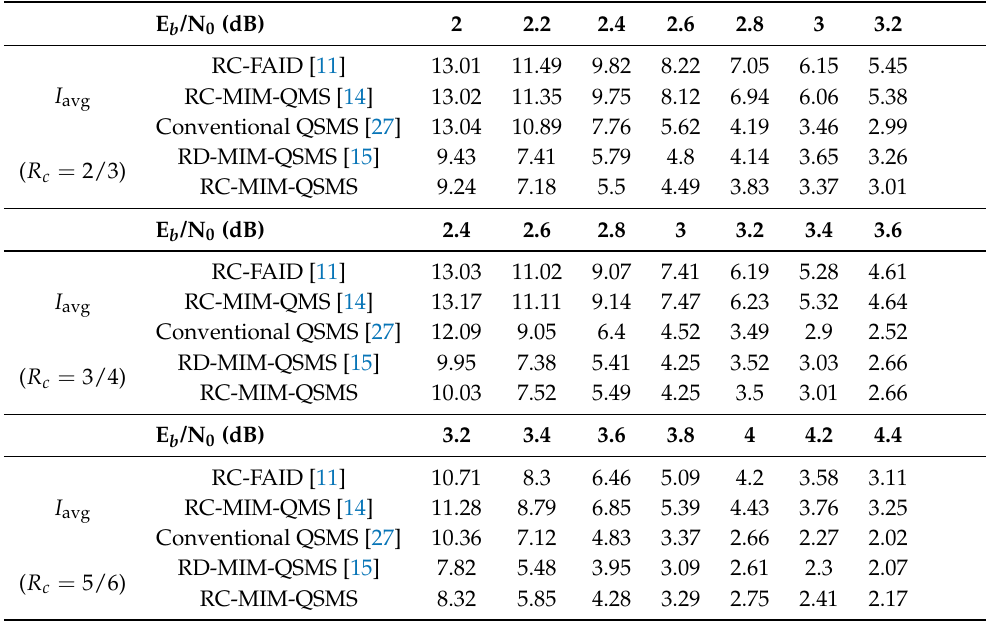
Table 3. The average number of iterations I avg of different LDPC decoders with q m = 4 for the 802.11n LDPC codes.